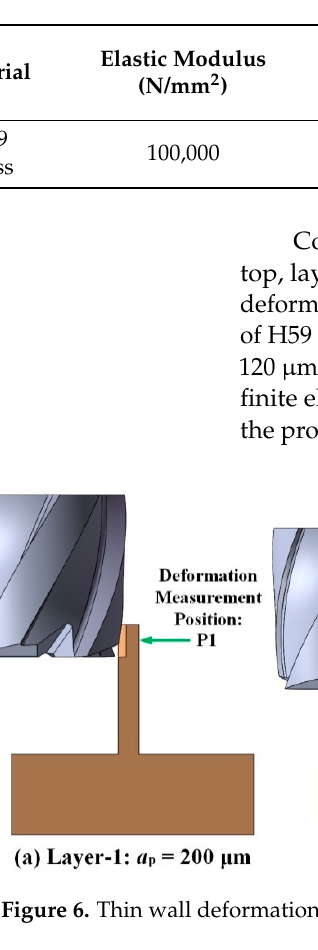
Table 2. Workpiece material properties.